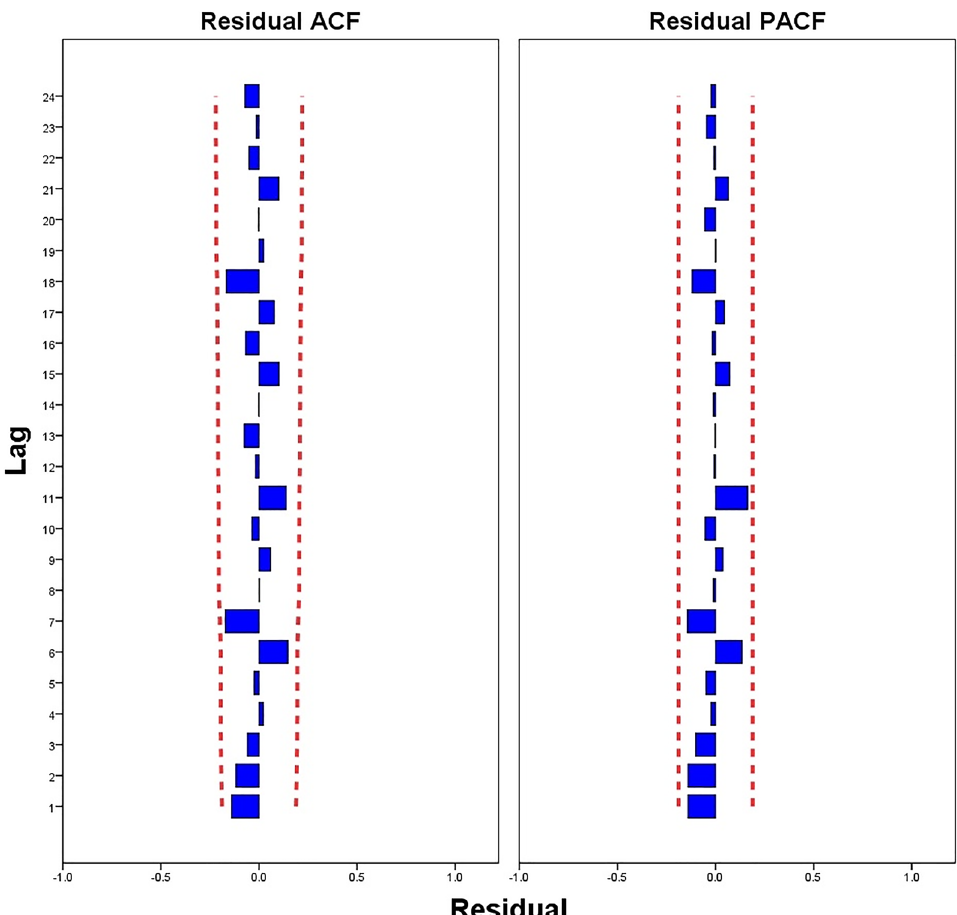
Figure.6. The residual ACF and PACF chart of the ARIMA(7,1,0)